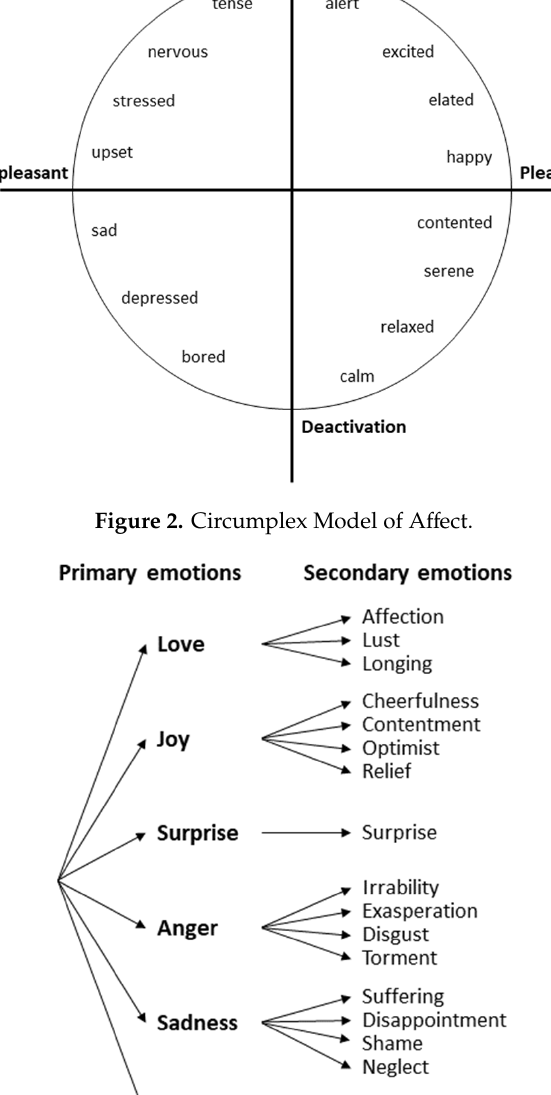
Figure 2. Circumplex Model of Affect.